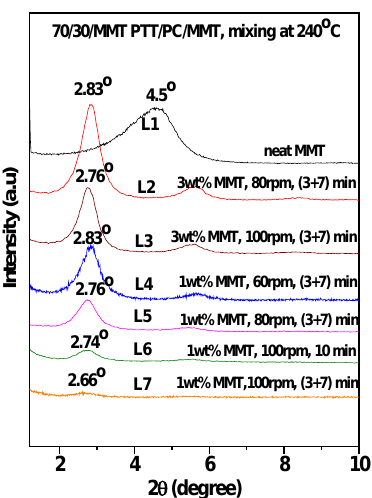
Figure 4. The wide-angle X-ray diffraction (WAXD) patterns of MMT (Cloisite ® 25A) in the 70/30 PTT/PC blends processed at 240 °C with indicated shear and processing mode.